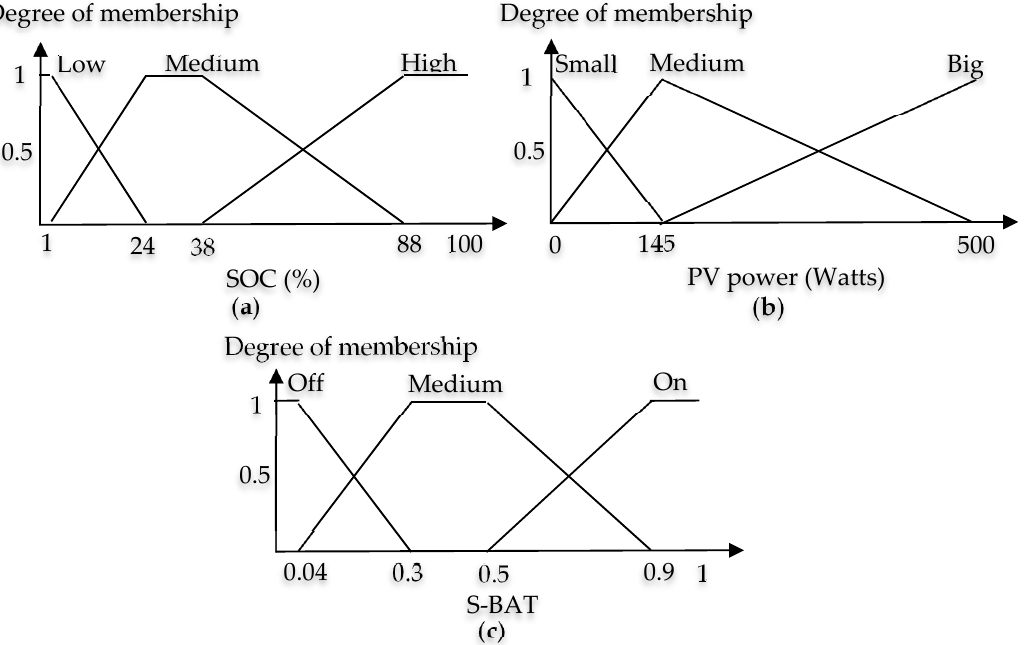
Figure 11. GAFLC membership functions of FLC-BAT: ( a ) membership function of the SOC variable; ( b ) membership function of the PV power variable; ( c ) membership function of the S-BAT variable.